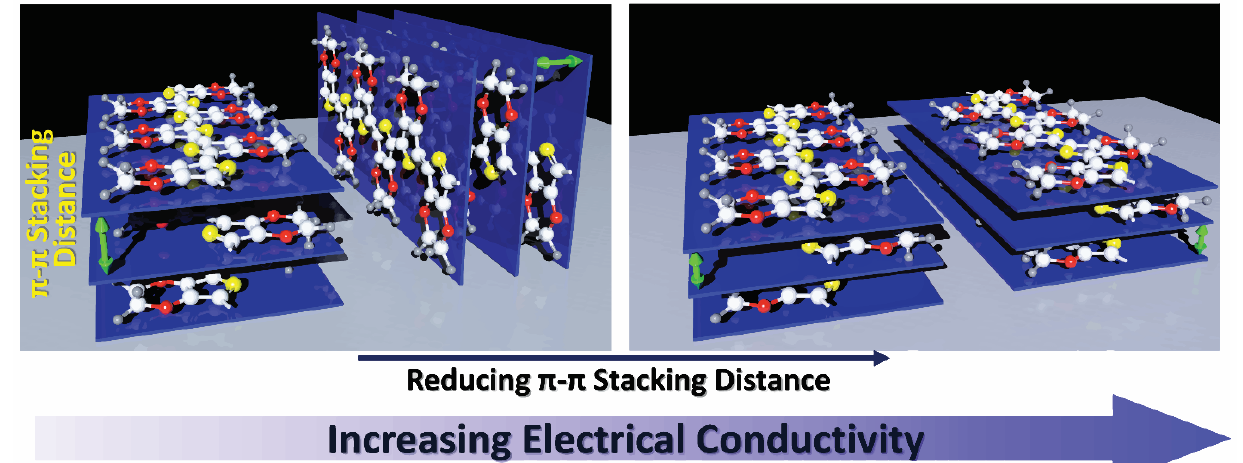
Figure 14. Reducing the π - π stacking distance in conjugated polymers [18]. A strong inter-chain coupling can be achieved with a short π - π stacking distance by adjusting the fabrication parameters and is desirable for electrical conductivity enhancement. Reproduced with permission [18]. Copyright 2020, Wiley.